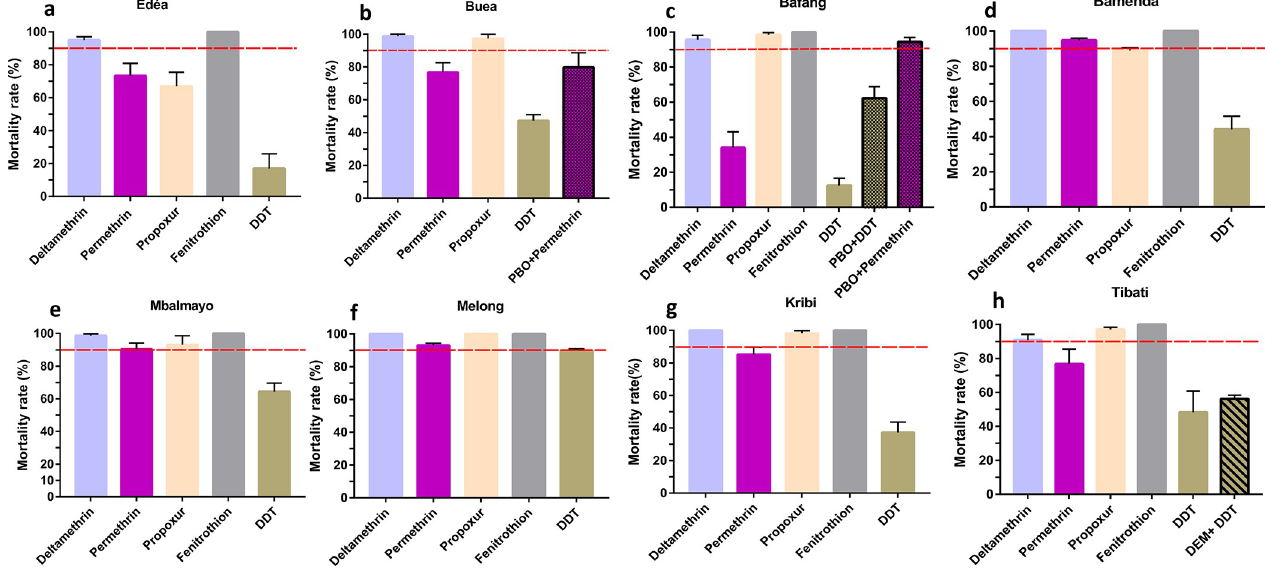
Fig 2. Mortality rates of adult A . albopictus from Cameroon (8 locations) 24 hrs after exposure to insecticides alone or with 1 h pre-exposure to synergist. a, Ede´a; b, Buea; c, Bafang; d, Bamenda; e, Mbalmayo; f, Melong; g, Kribi; h, Tibati. Error bars represent standard error of the mean (SEM). DDT, Dichlorodiphenyltrichloroethane. PBO, Piperonyl butoxide. DEM, Diethyl maleate.